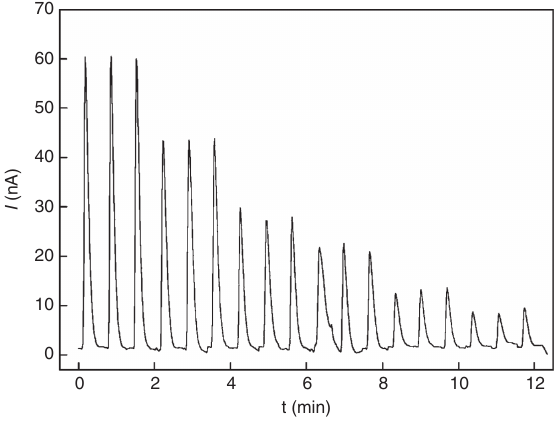
Figure 2 Amperometric response of carbon paste electrode in flux injection analysis of benzocaine with concentration 10; 8; 6; 4;